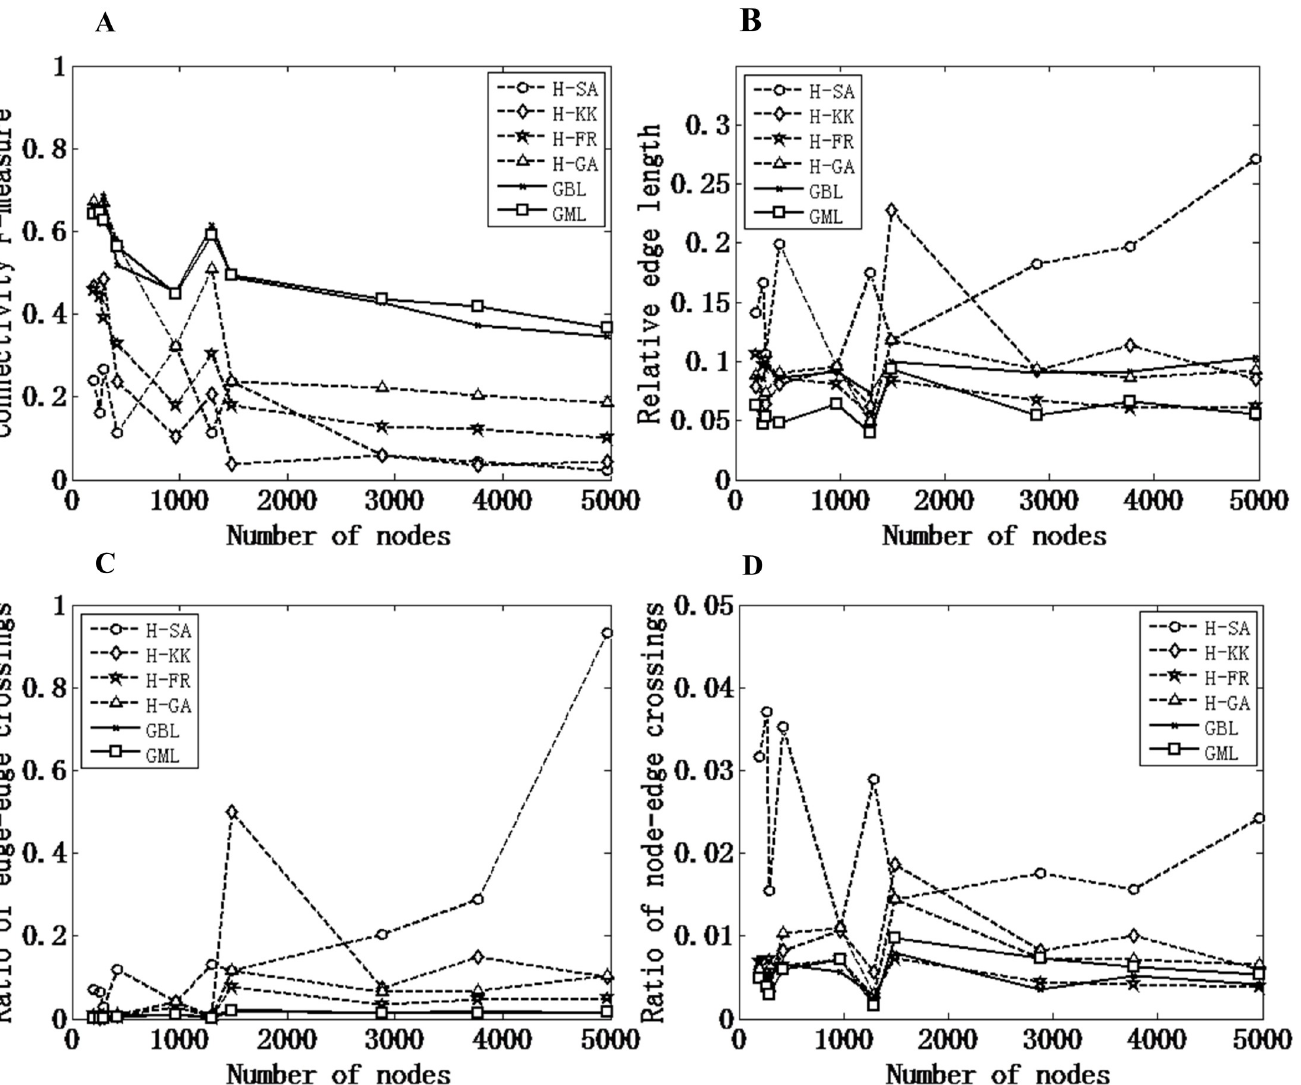
Fig 6. Characterization of the GML algorithm. The hybrid layout algorithms with different preprocessors (H-SA, H-KK, H-FR, and H-GA) and GBL are used as reference methods for comparison purposes. A) connectivity F-measure, B) relative edge length, C) ratio of edge-edge crossings, and D) ratio of node-edge crossings.